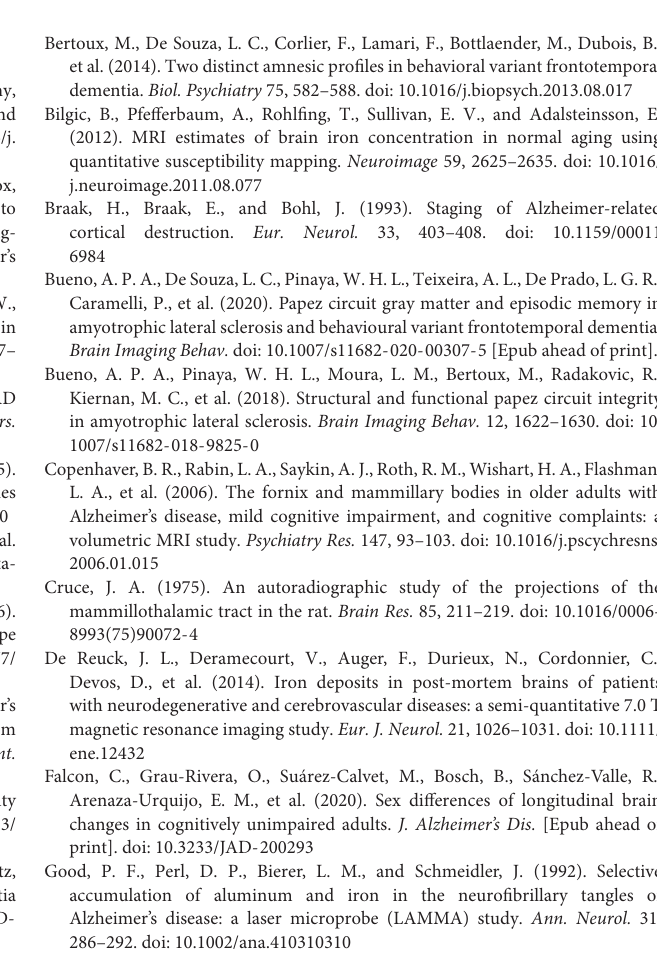
TABLE S1 | The T1W based volume, mean susceptibility and maximum susceptibility are presented, along with paired t -test results between the left mammillary body and right mammillary body for MCI patients and HCs. TABLE S2 | Independent-sample t -test analyses between genders, aMCI and naMCI patients, MCI patients with APOE ε 4 and without APOE ε 4 for total volume and mean susceptibility in the mammillary